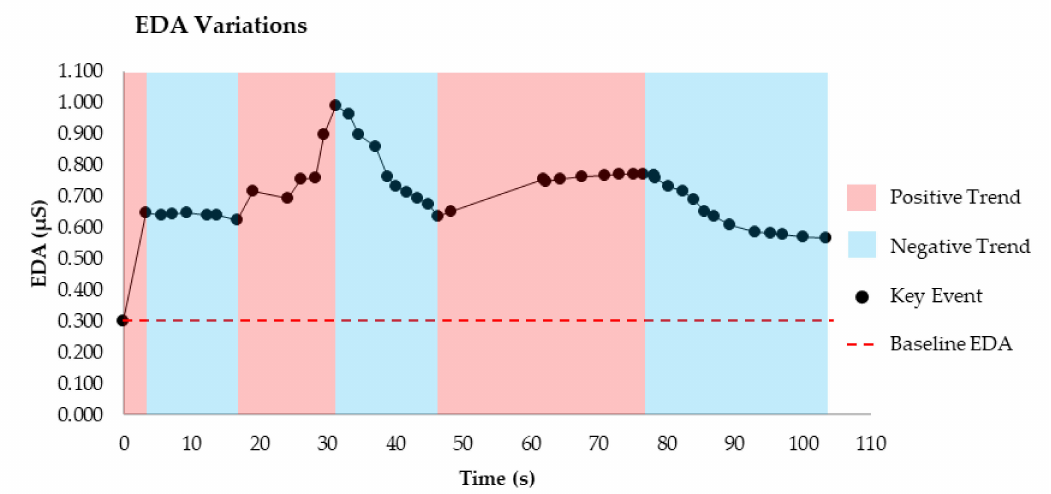
Figure 3. Exploring increases and decreases in EDA in the